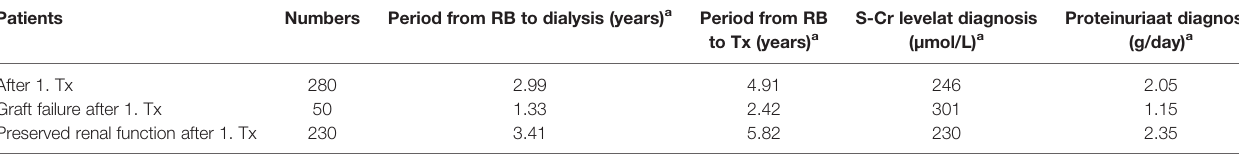
TABLE 1 | The evaluation of 313 Czech patients with histological diagnosis of IgAN (30 patients with two kidney transplantations, 3 patients with three kidney transplantations). Patients